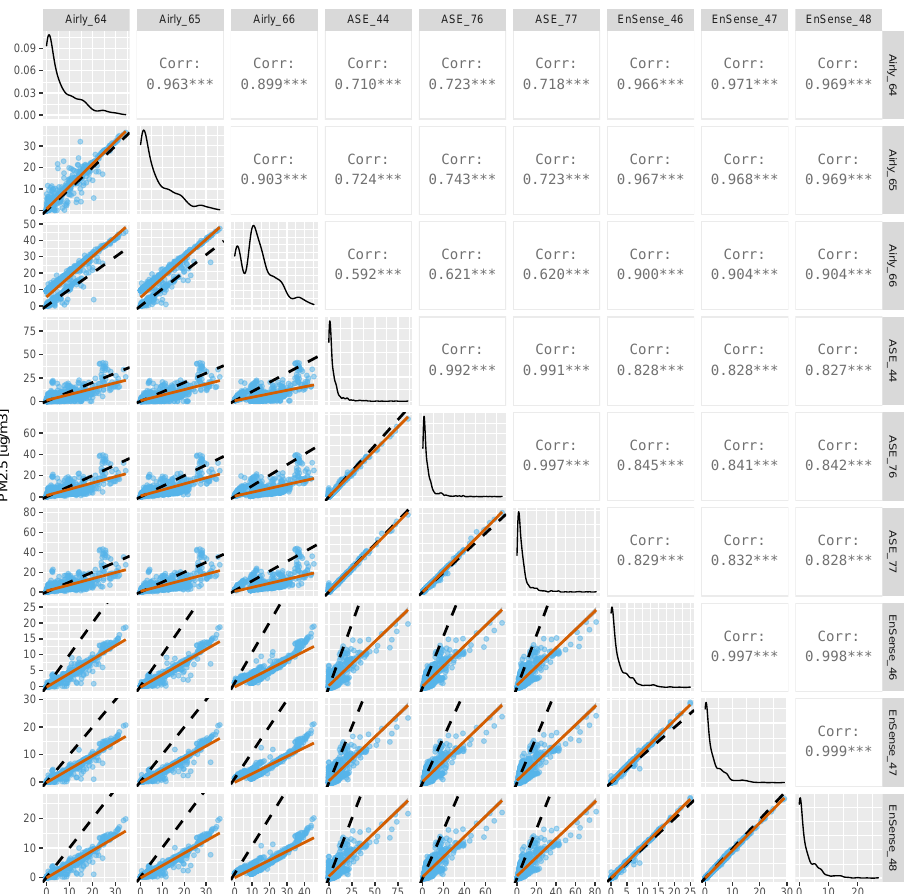
Figure 5. Sensor-to-sensor intercomparison of the factory-calibrated PM 2.5 signal of all sensors systems against each other during the co-location period. Axes labels are shown here in units of µg m − 3 . The lower left panels show scatterplots of one sensor’s output against the other (with the black dashed line indicating the 1:1 reference line and the red line a linear regression fit to the data). The panels on the diagonal show the probability density function of the readings of each individual sensors. The panels on the upper right show the Pearson correlation of the scatterplots on the lower left *** means the correlation is